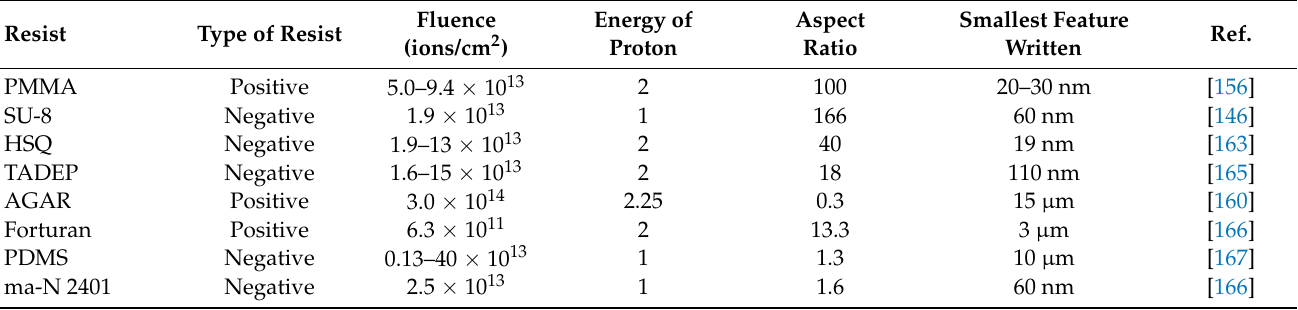
Table 5. Resists for proton beam